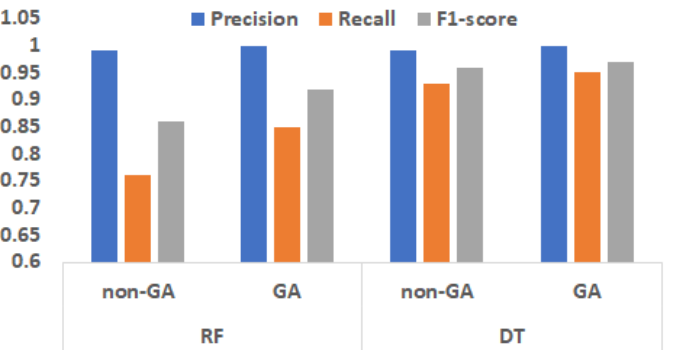
Figure 9. Comparison of the RF and DT-based classifier with and without the use of GA-based feature